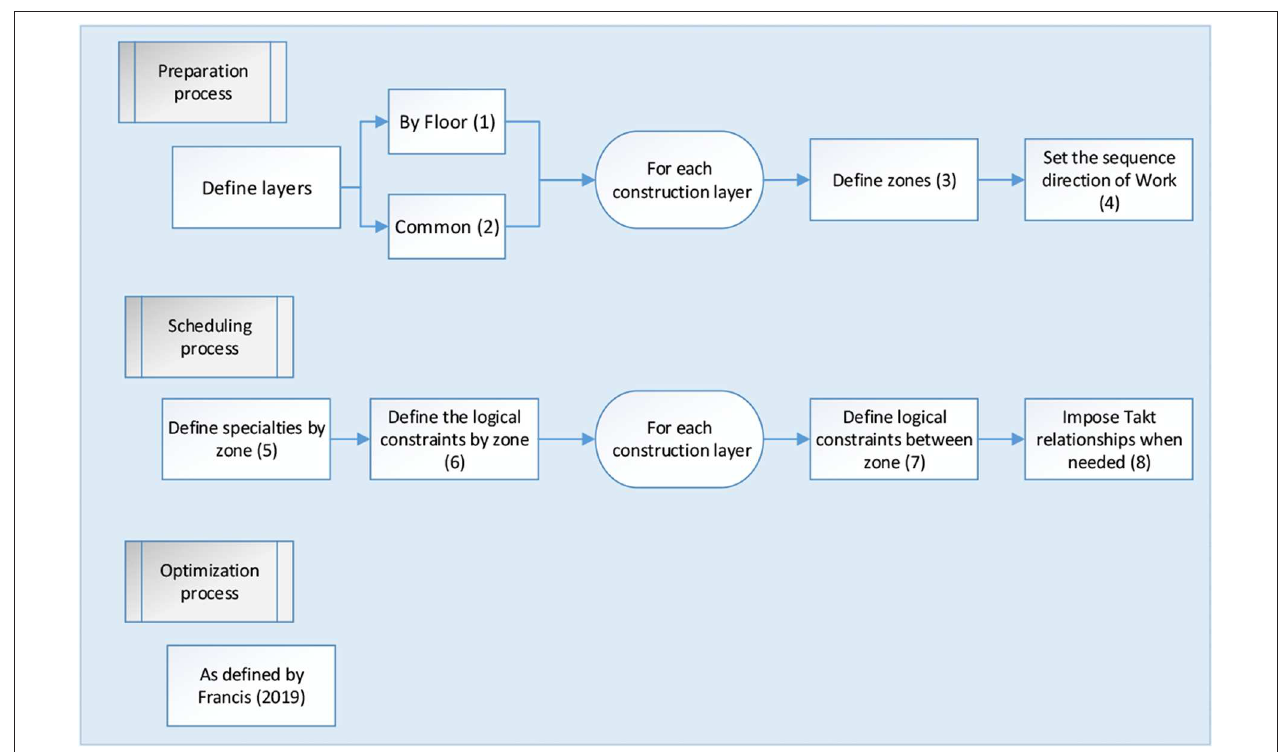
FIGURE 2 | The construction operations scheduling